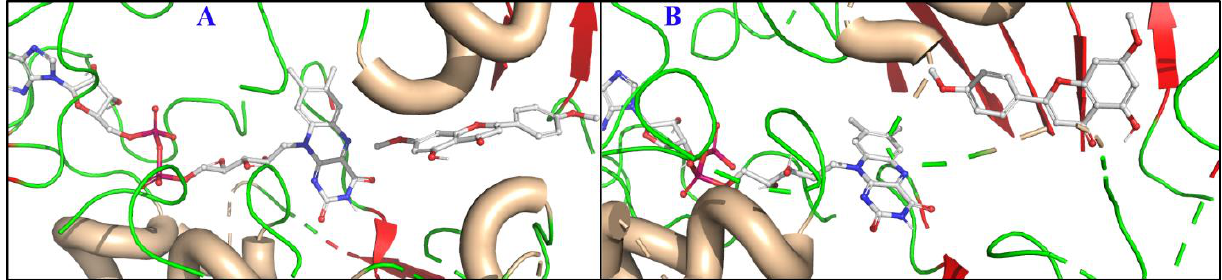
Figure 3. The two binding modes of acacetin 7- O -methyl ether. ( A ): Pose 1 with benzopyranone facing the FAD. ( B ): Pose 2 with the methoxyphenyl group facing the FAD. The protein is shown as a cartoon (helices are colored wheat, strands are colored red, and loops are colored green) and the ligands as sticks.